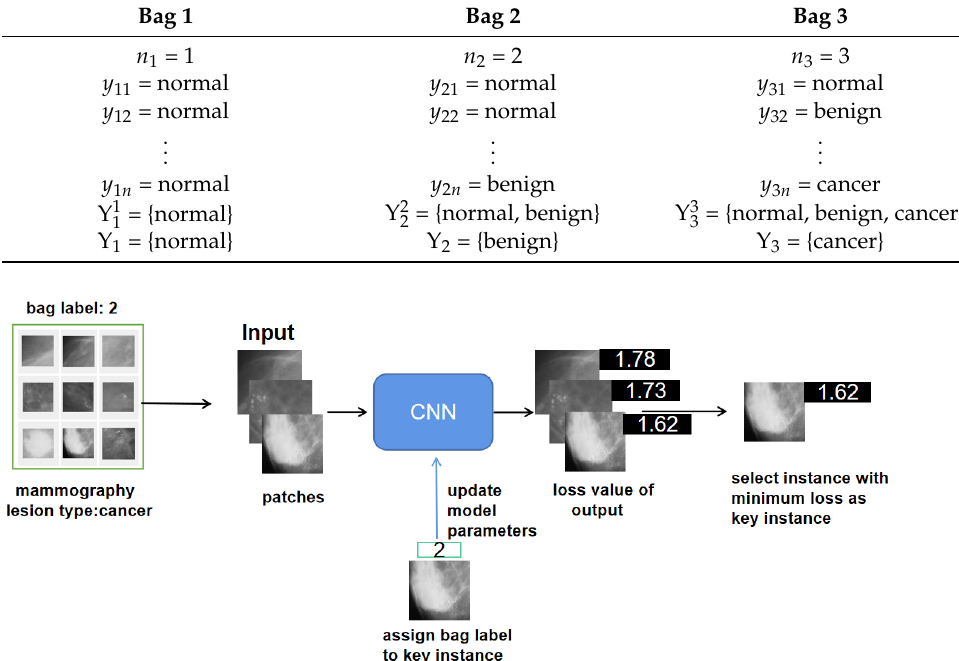
Table 3. Instance labels and bag labels of the proposed model.